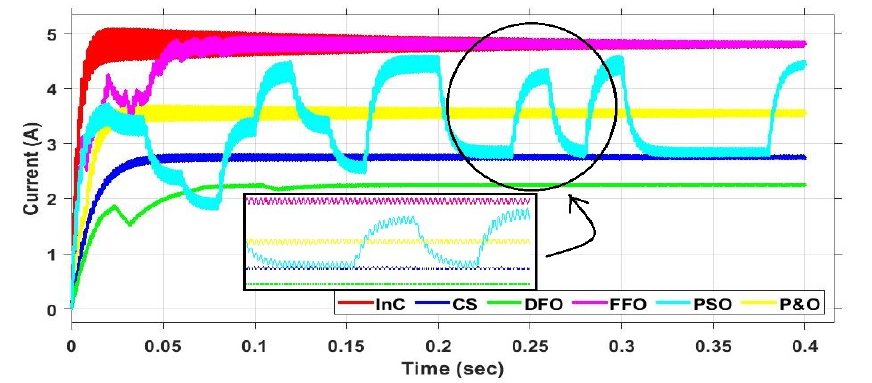
Figure 17. PS2 current comparison between all algorithms for centralized PV